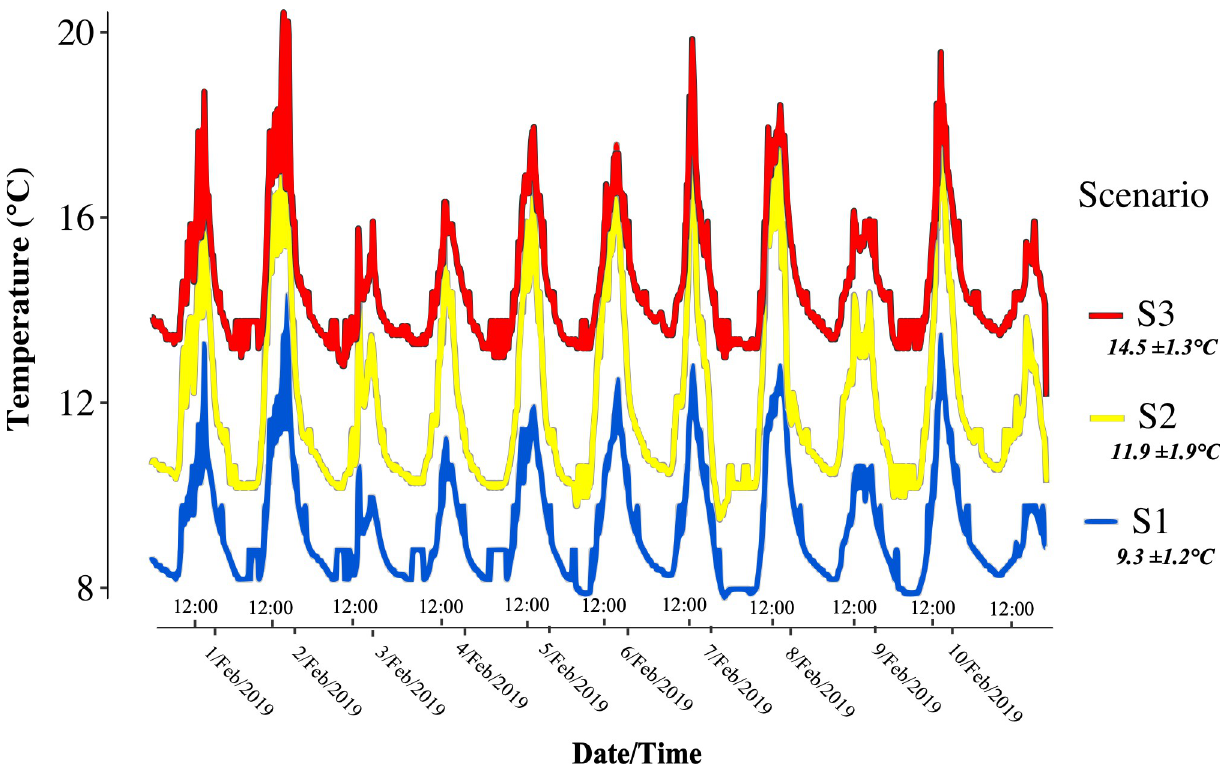
Fig 2. Water temperature during the microcosm experiment. HOBO data loggers recorded temperatures (1162 sampling points) from chambers in the control/ambient [ S1 ] scenario (blue), +2.5˚C [ S2 ] scenario (yellow), and +5˚C [ S3 ] scenario (red) throughout the 10-day experiment. The X-axis shows recorded temperatures from the HOBO data logger with date and hour (12:00 pm). The Y-axis represents the temperatures in degrees Celsius (˚C).